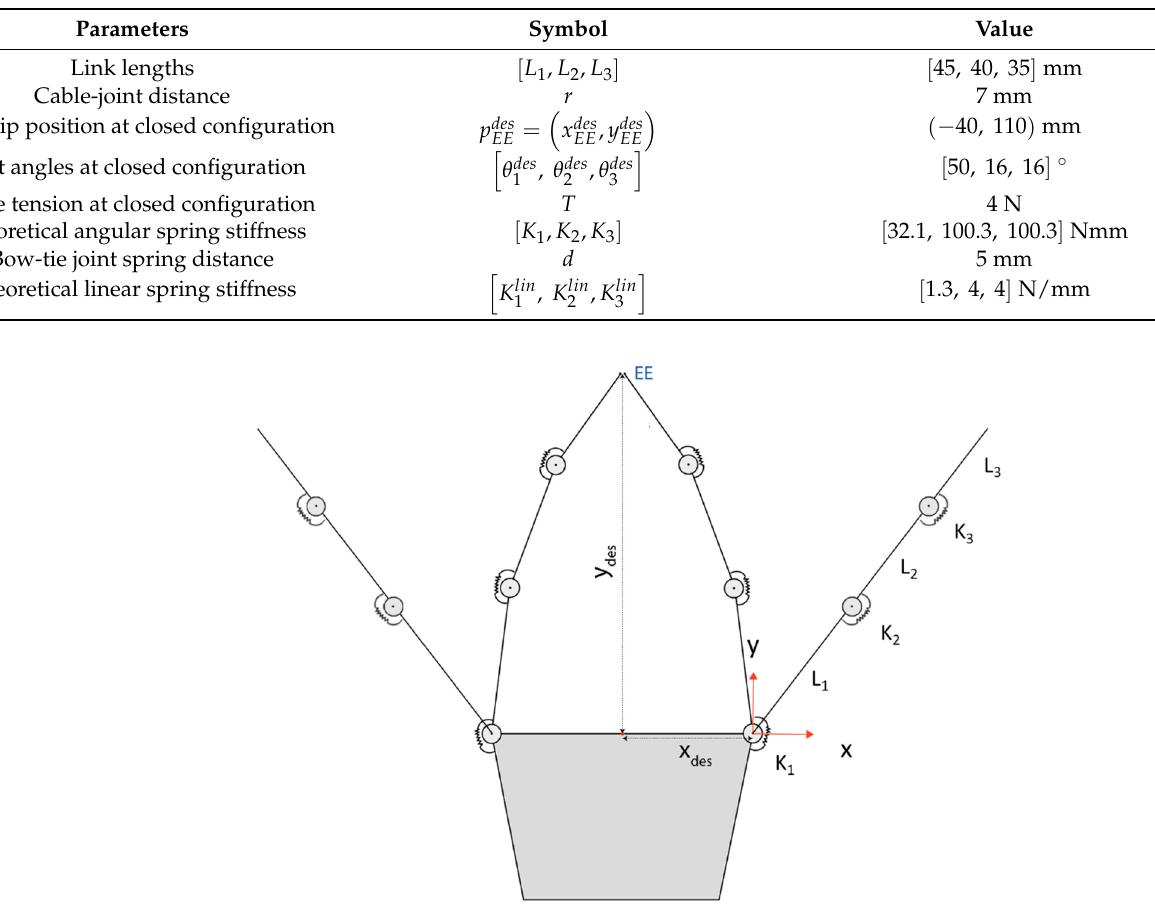
Figure 4. 2D Schematics of the gripper in the closed configuration for which the fingertips touch each other in the point ( x des , y des )